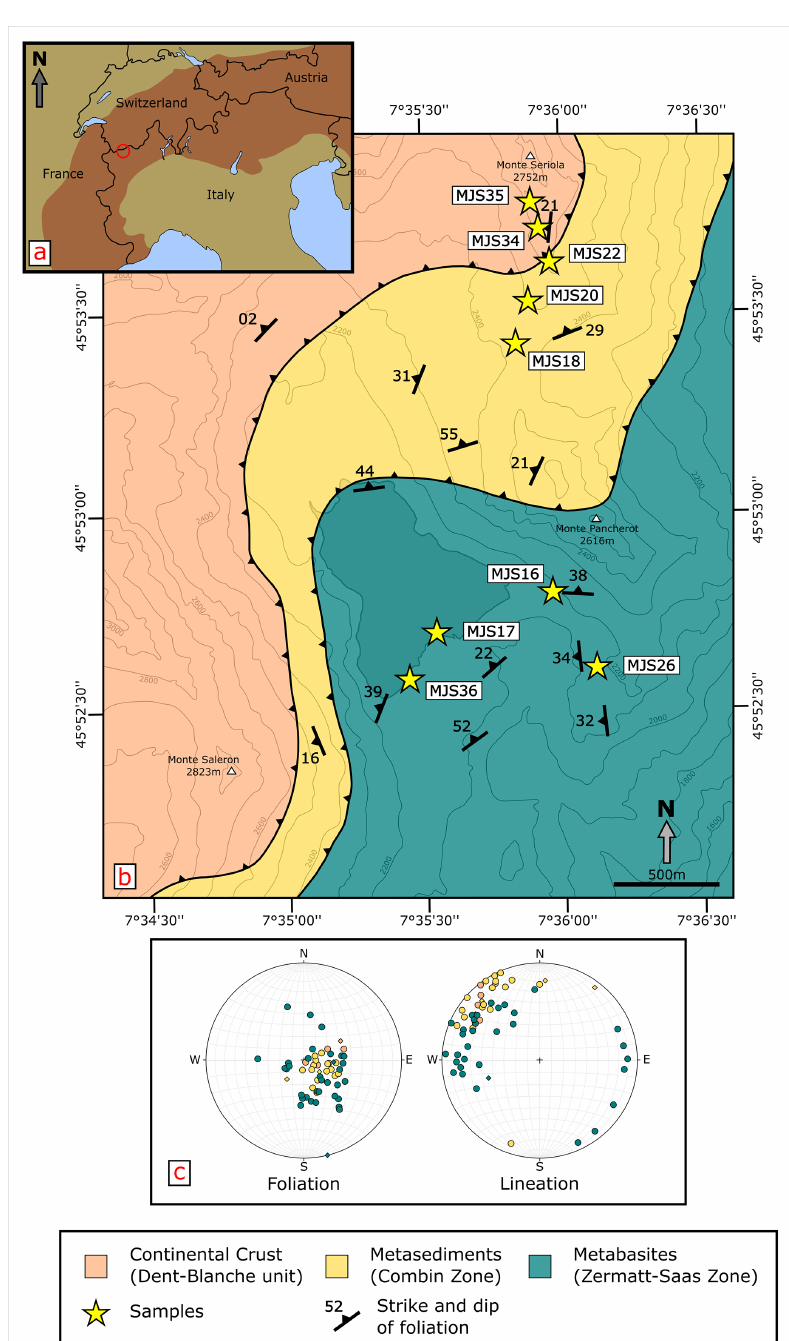
Figure 1. (a) Miniature map displaying approximate location of the study area in the European alpine orogen. (b) Geological map of the study area at Lago di Ciganan, in the western Italian Alps, modified after the map of Kirst and Leiss (2016). Sample locations indicated by stars. (c) Stereoplots of foliation normal and stretching lineation as equal area projections in the lower hemisphere. Data compiled from our own measurements (diamonds) and from Kirst and Leiss (2016) (circles); colors match those used in the